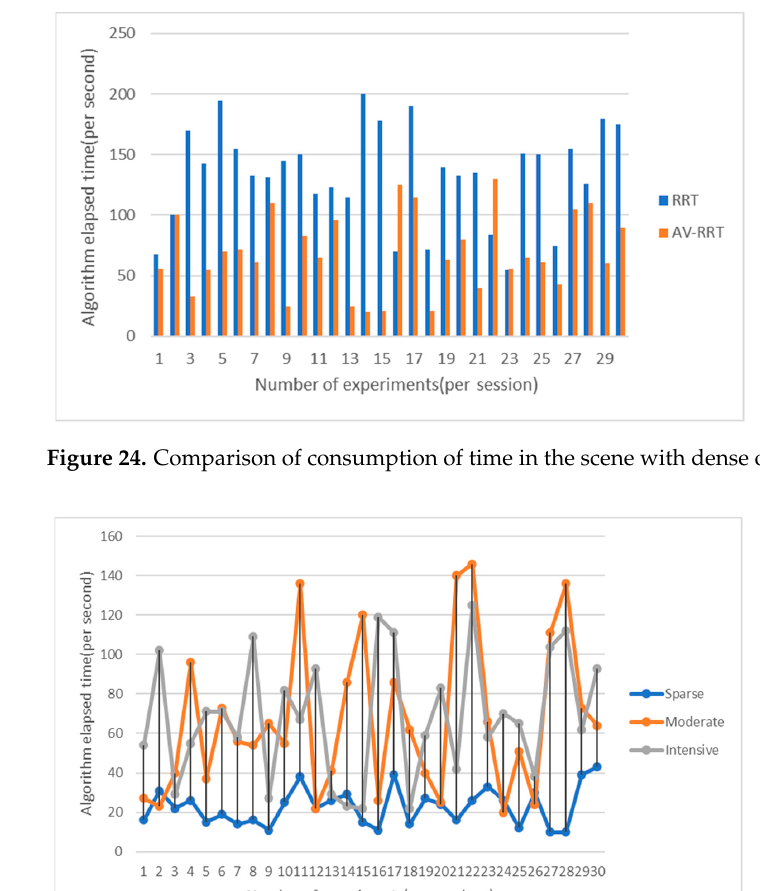
Figure 23. Comparison of consumption of time in the scene with moderate obstacles.